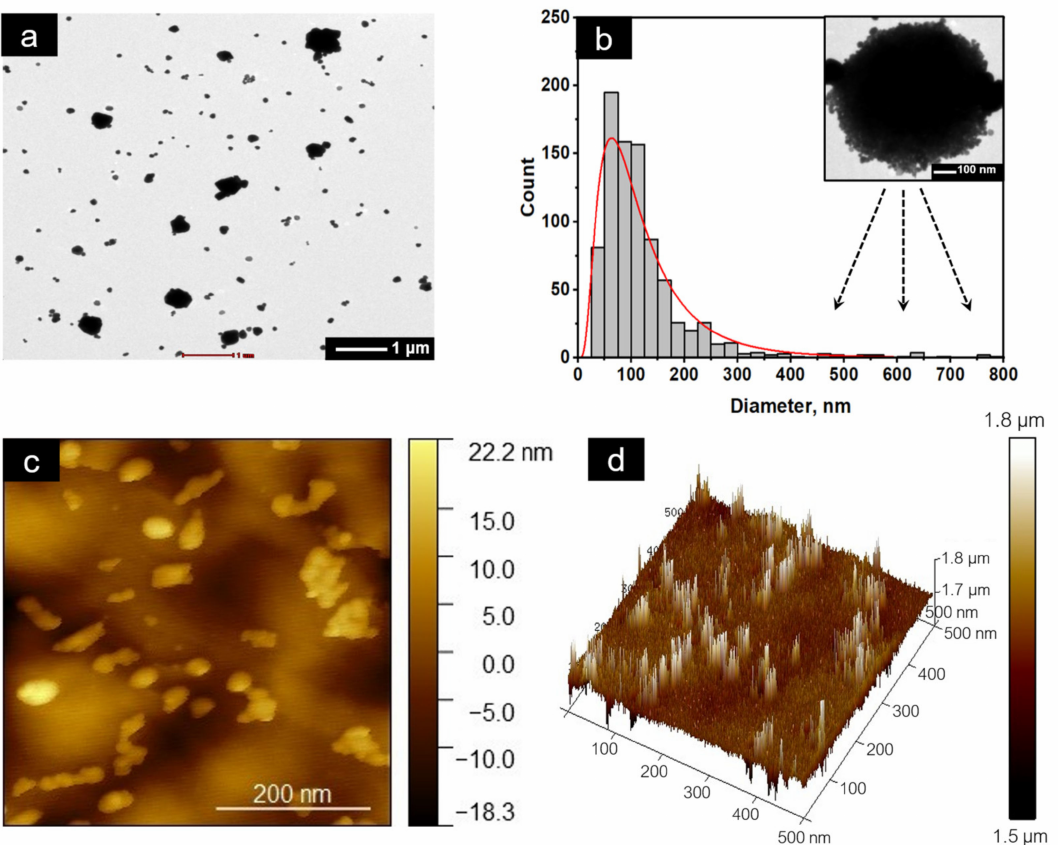
Figure 6. ( a ) TEM image of the AgNPs; ( b ) corresponding particle size distribution and morphology of the aggregated AgNPs; ( c ) 2D AFM image; ( d ) height analysis in